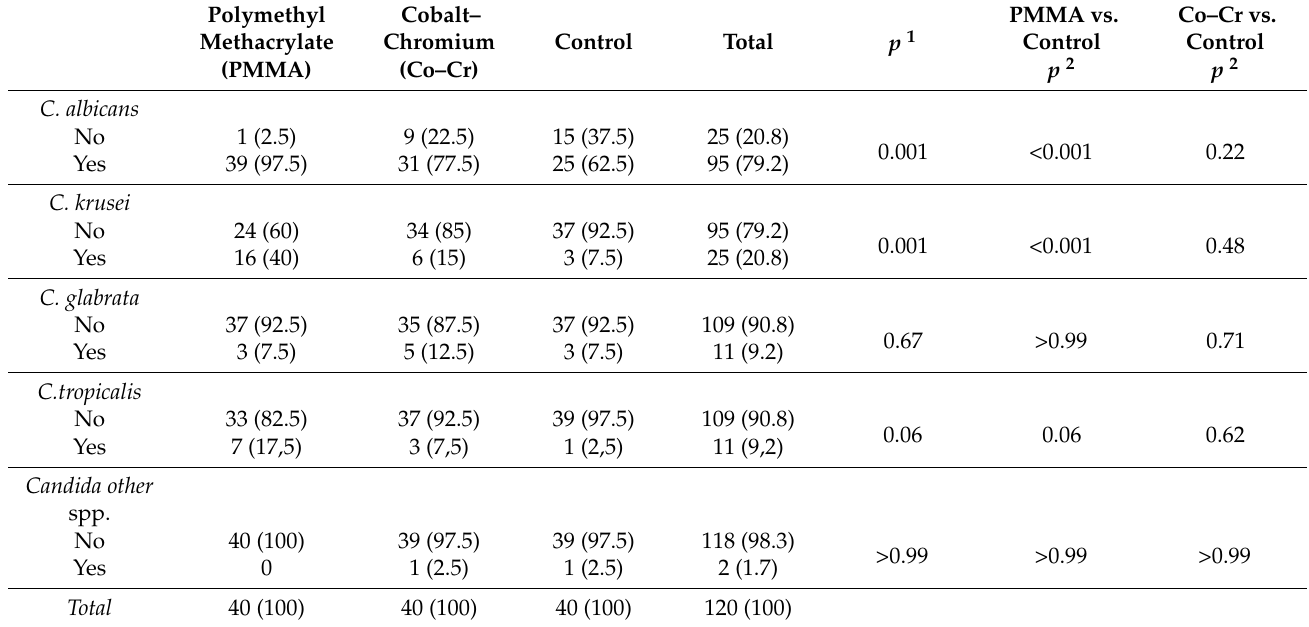
Table 3. Distribution of Candida species in test groups.